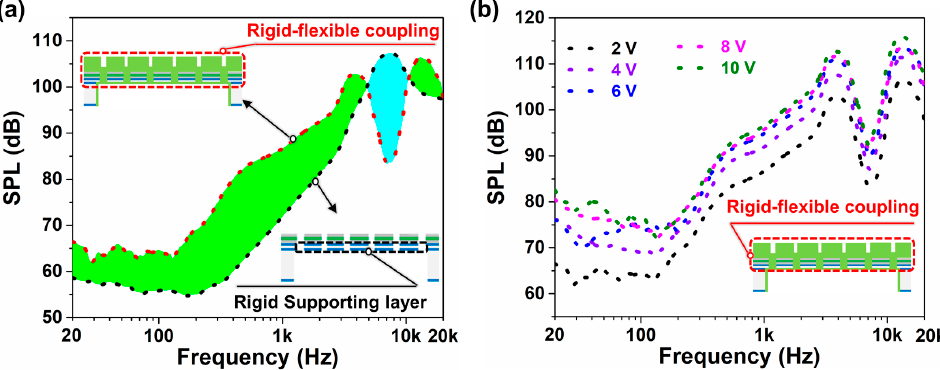
Figure 3. Measured SPL. ( a ) Comparison of SPL of a piezoelectric MEMS speaker with rigid sup- porting layer and rigid–flexible coupling one. ( b ) Measured SPL of piezoelectric MEMS speaker at di ff erent driving voltages.